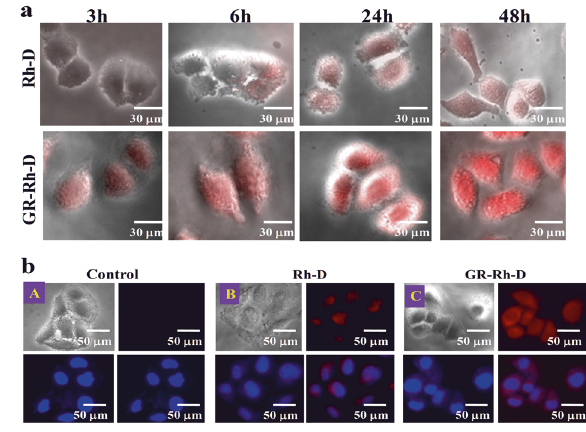
Fig. 5 Cellular uptake analysis using rhodamine B. a Phase-contrast images of HeLa cells treated with pure drug and drug loaded in brush copolymers after incubation for varying time interval. b DAPI stained (blue channel) images of the cell after the treatment with pure drug and drug-loaded brush copolymers. Where the top left is bright fi eld images of cells, top right is rhodamine tagged drug in pure form (red channel) (B) and loaded in brush polymer (C), bottom left denotes cells stained with DAPI (blue channel) and the bottom right is merged image of red and blue